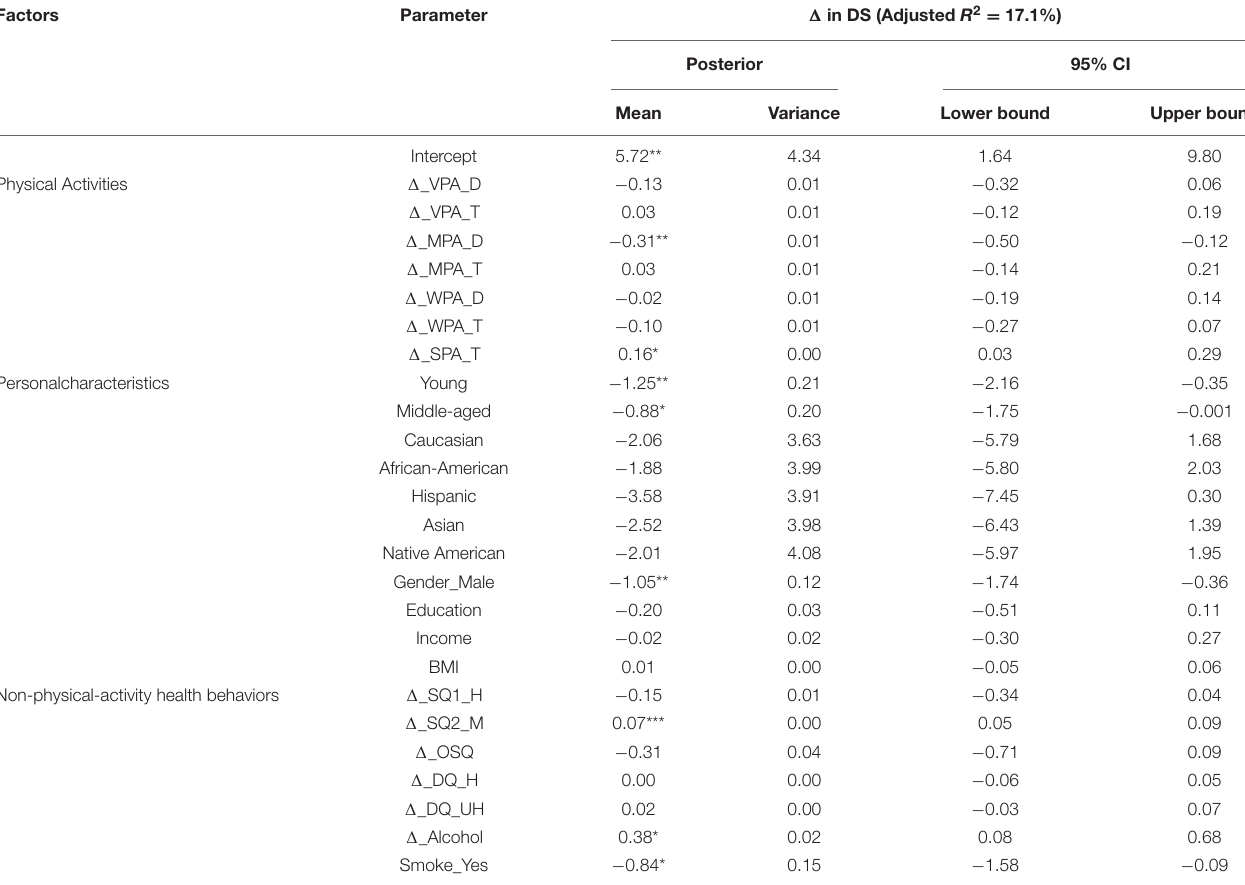
TABLE 3 | The results of Bayesian regression analysis of changes in physical activity on depressive symptoms.